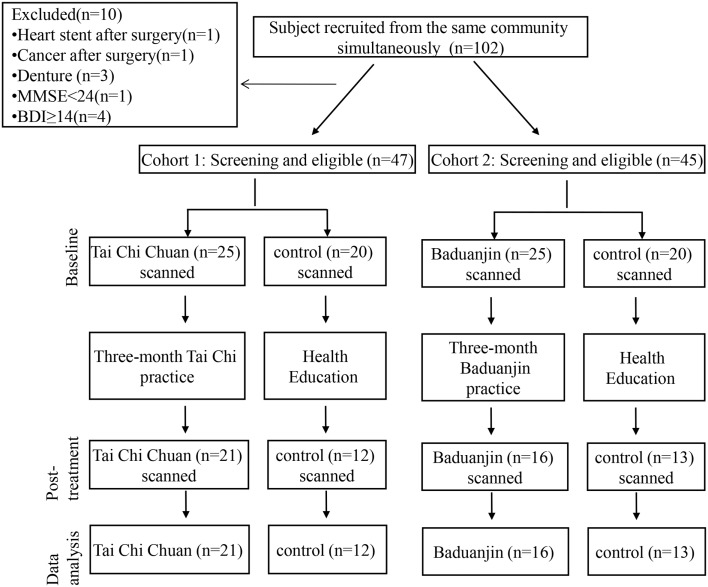
Flow diagram for the screening, randomization, and completion of 12-week evaluations.